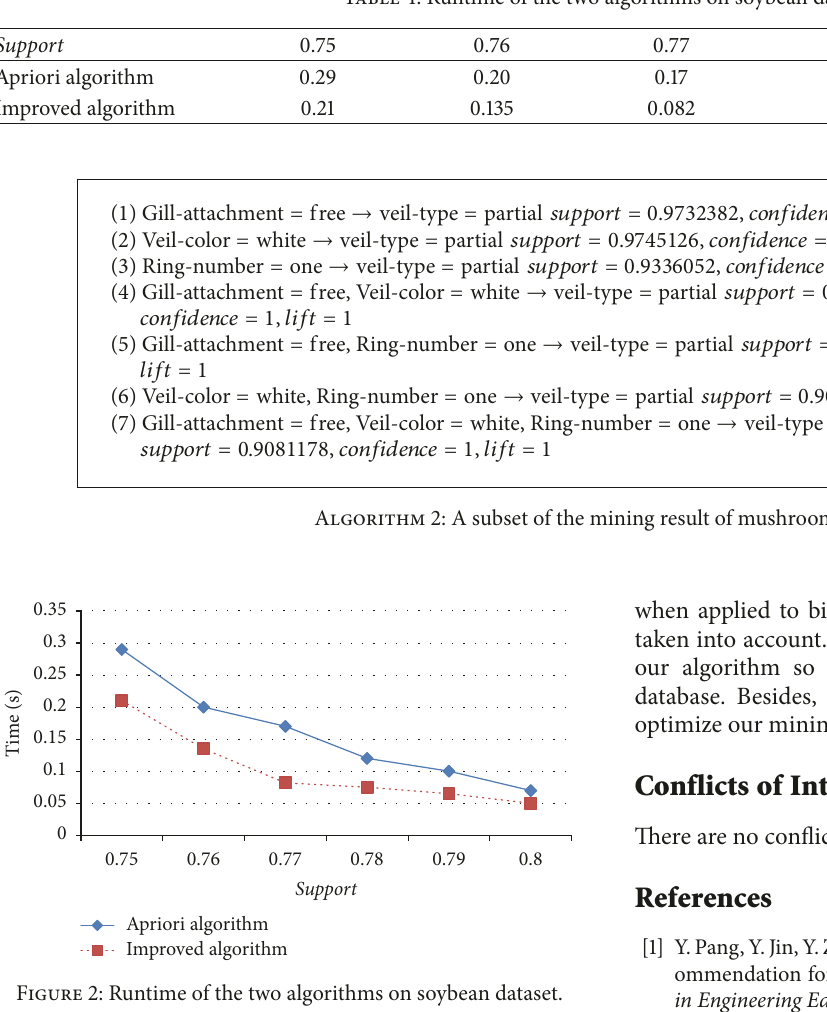
Table 4: Runtime of the two algorithms on soybean dataset.